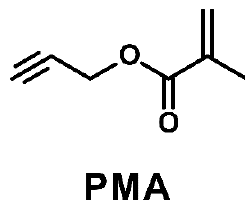
Table S1, such as vinylene carbonate (VC) [8–12], borate/boronic acid [13,14], vinyl